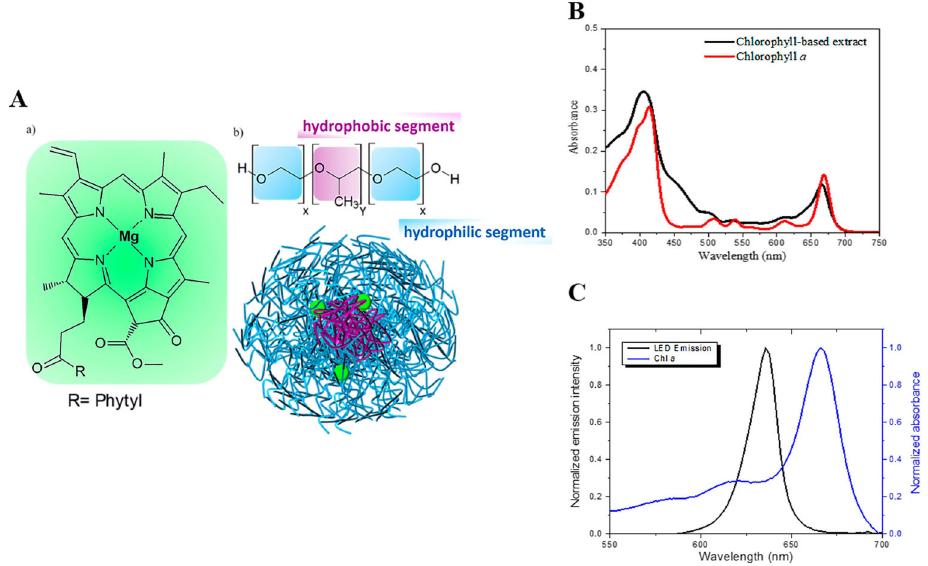
Figure 1. Schematic representation of the encapsulation of chlorophyll- a (Chl -a ) into a P123 micelle and its absorption spectra. A , Chemical structure of ( a ) Chl -a in inclusion to ( b ) P123 triblock copolymer (x=20 and y=70). B , UV-Vis absorption spectra for Chl -a (1.25 mg/L) and chlorophyll-based extract (22 mg/L) incorporated into the 2% (m/v) P123 micellar system. C , Normalized absorption spectra UV-Vis (Chl -a in P123) superimposed to the red light-emission diode